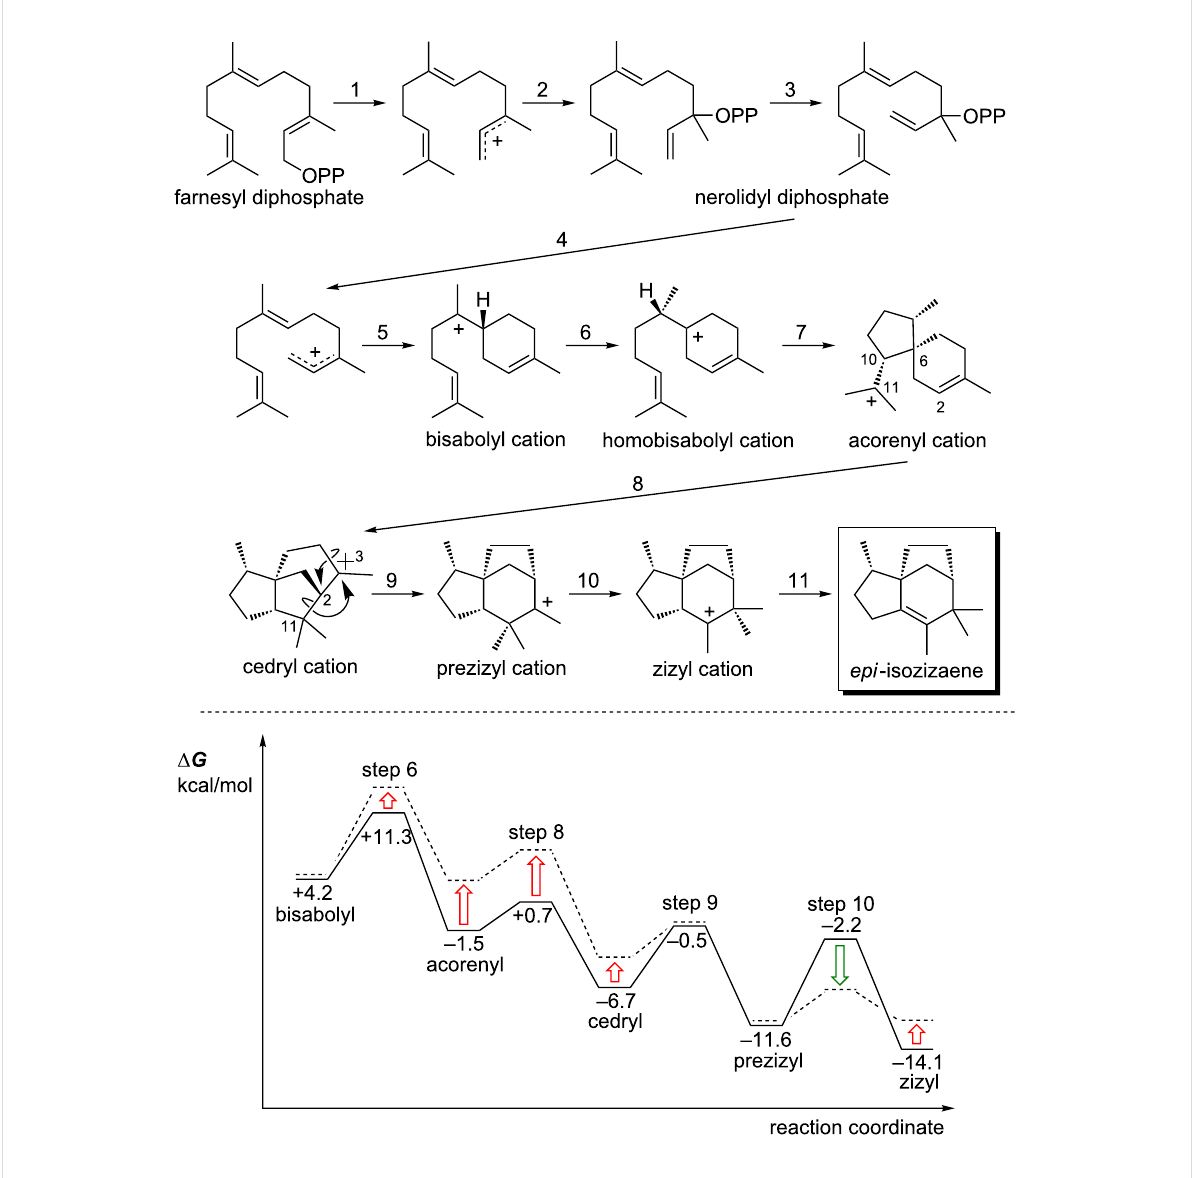
Figure 11: Top: carbocation rearrangements involved in epi -isozizaene formation. Bottom: reaction coordinate diagram for conversion of the bisabolyl cation to the zizyl cation in the absence (solid lines; computed relative energies in kcal/mol) and presence (broken lines) of epi -isozizaene